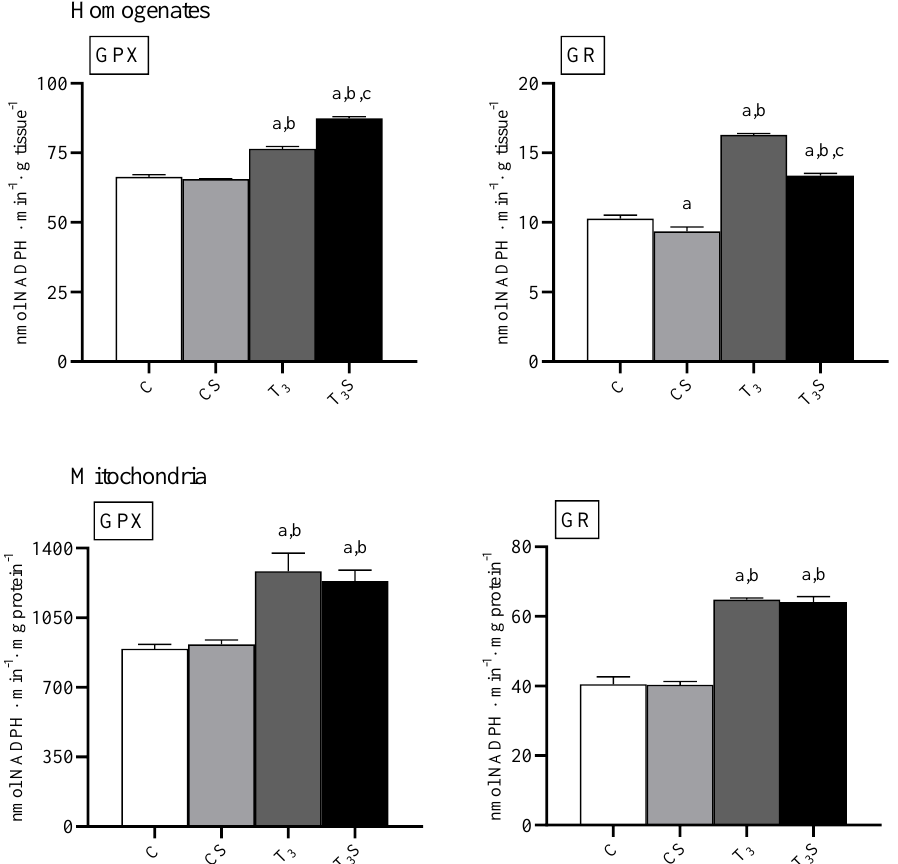
Figure 5. Activity of the antioxidant enzymes glutathione peroxidase (GPX) and glutathione reductase (GR) in rat liver homogenates and mitochondria from: C, control rats; CS, control rats fed with Chlorella sorokiniana ; T 3 , rats made hyperthyroid by ip. T 3 administration; and T 3 S, hyperthyroid rats fed with Chlorella sorokiniana . The values are the means ± S.E.M of the data obtained on eight different livers. a significant vs. C, b significant vs. CS, and c significant vs. T 3 . The level of significance was chosen as p < 0.05.